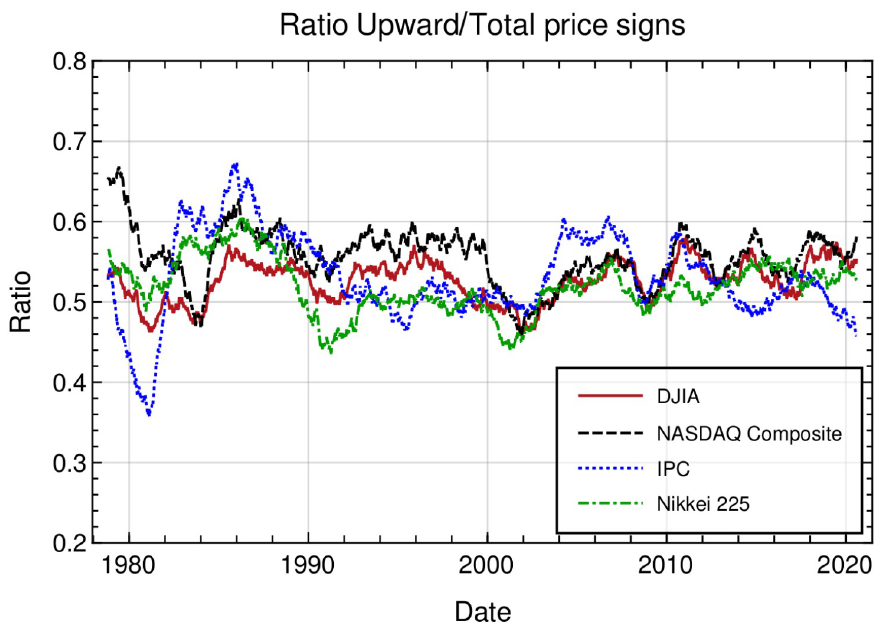
Fig 3. Ratio of upward to total price changes in daily data, plotted against time for the interval from 10–30-1978 to 08–07-2020, calculated over a time window of 504 trading days.